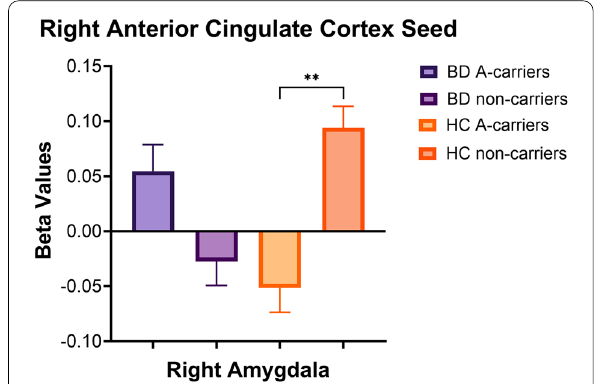
Fig. 3 Interaction between bipolar disorder (BD) diagnosis and CACNA1C rs1006737 on rsFC between the right anterior cingulate cortex seed and right amygdala. Beta values correspond to Fischer-transformed correlation coefficient values, adjusted for age, 0.02). sex, and race. Error bars denote standard error of the mean. HC = healthy controls. ** p < 0.01